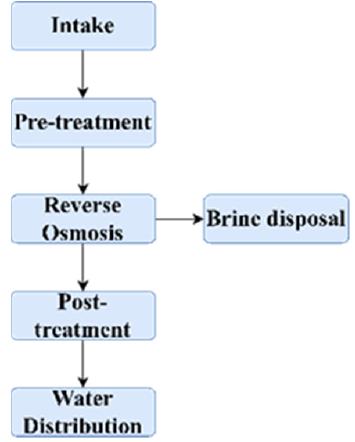
Figure 2. Flow diagram of water desalination.